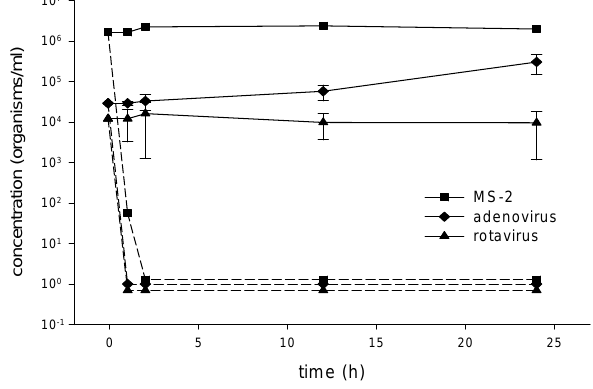
Figure 2: Adenovirus Type 5 and MS-2 inactivation in three replicate experiments conducted in limed water at room temperature.